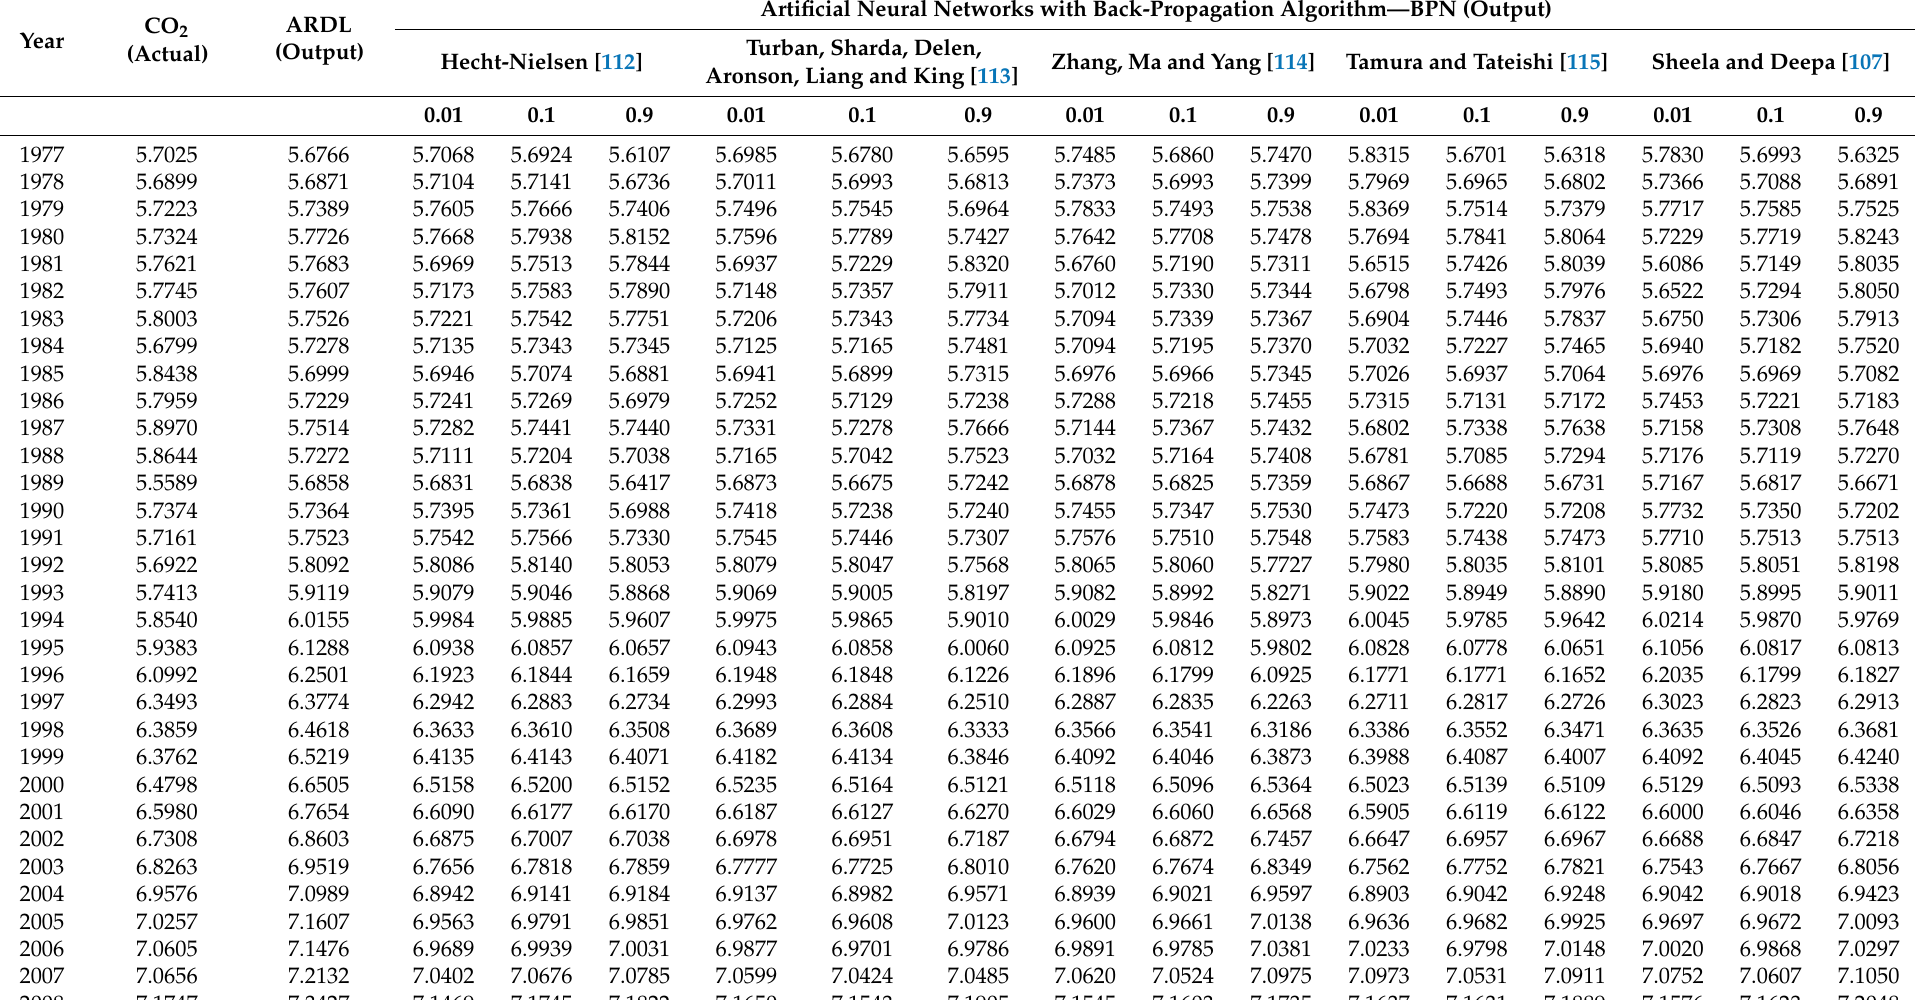
Table A6. The output values from the ARDL and BPN